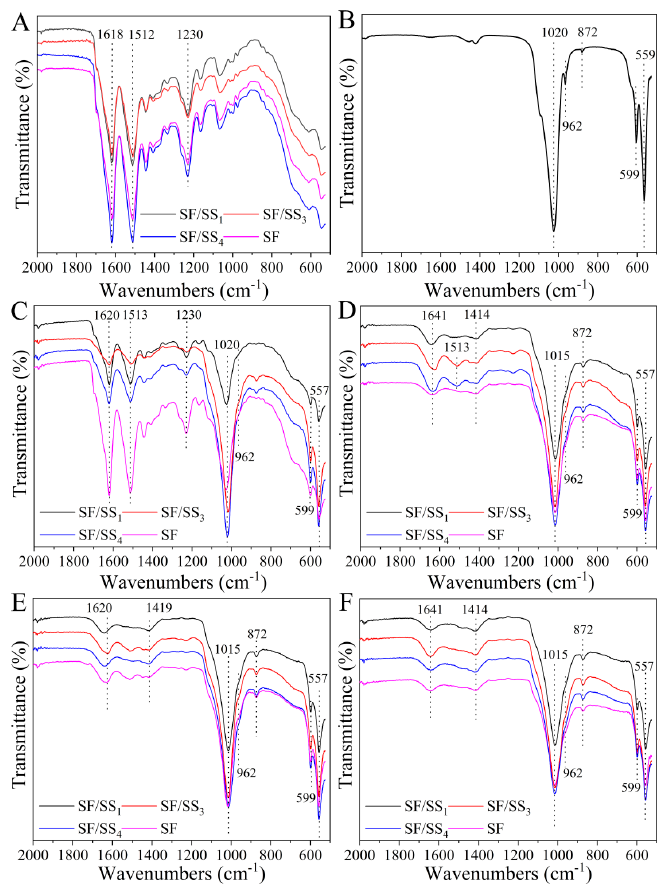
Figure 9. AIR-FTIR spectra of SF/SS composite films after mineralization. ( A ) Unmineralized, (B ) HAp, ( C ) 1 d, ( D ) 3 d, ( E ) 5 d, ( F ) 7 d.